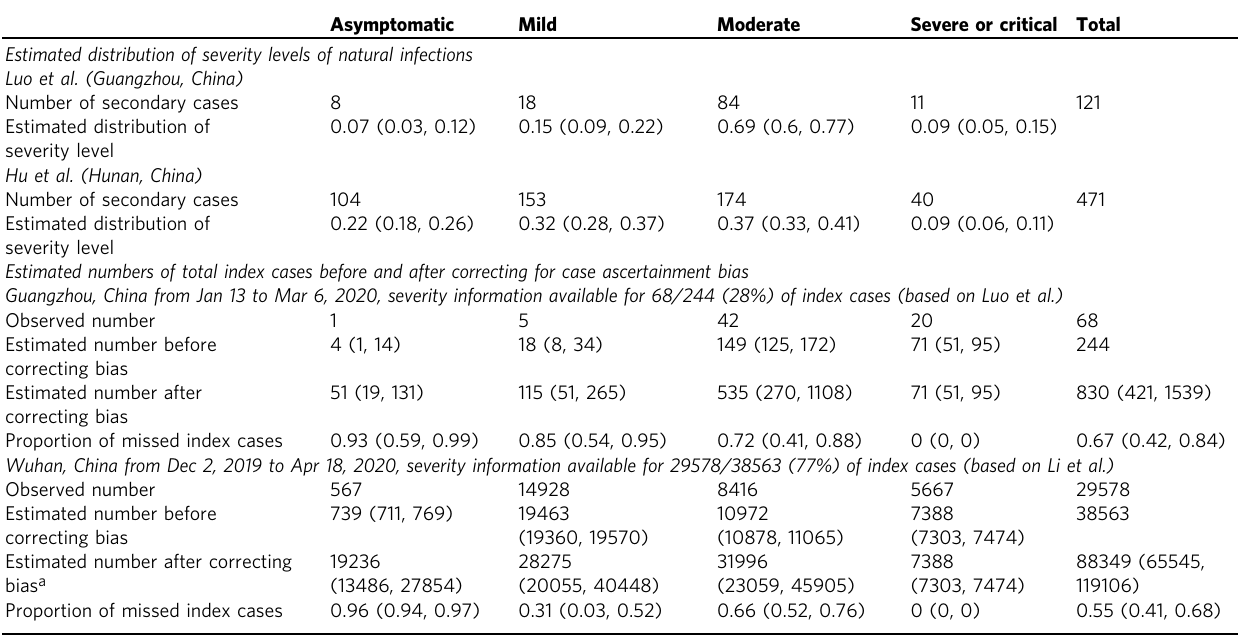
Table 2 Observed number of secondary cases by reported severity level for COVID-19 in China, and the estimated distribution of severity levels of natural infections based on secondary